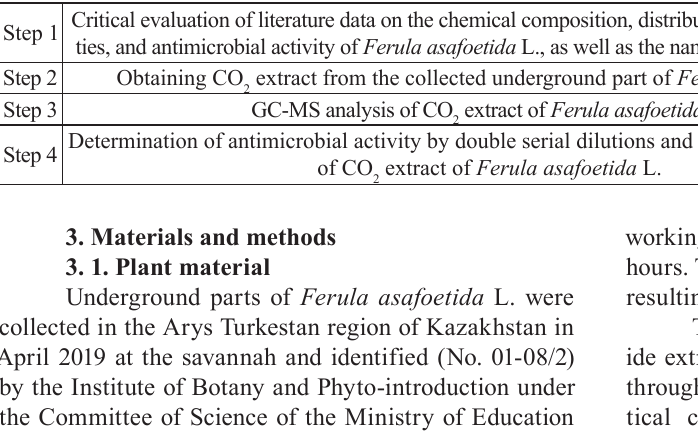
Planning of the